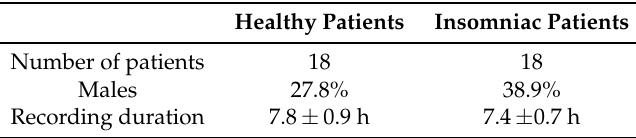
Table 1. Information about polysomnography (PSG) recordings of tested group of healthy individuals and insomniac